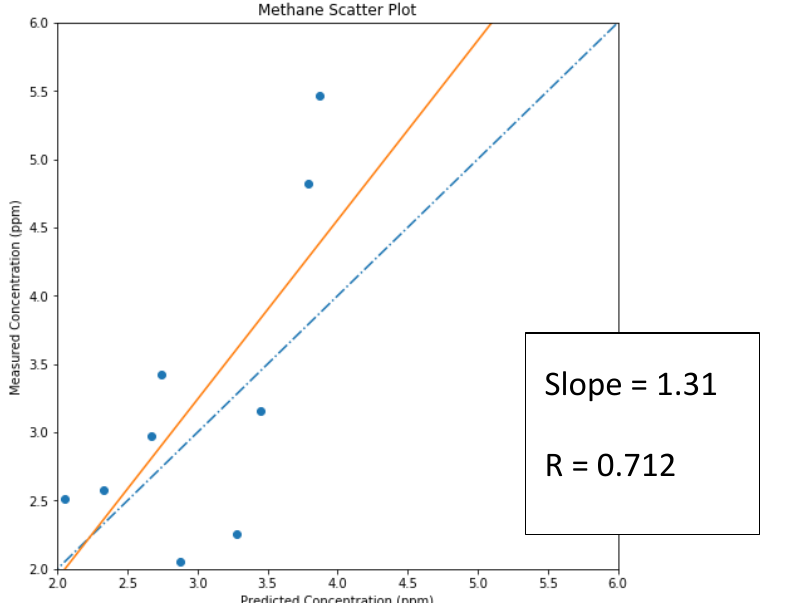
Figure 11. Scatter plot of measured methane concentrations versus modeled concentrations for 14 September 2021, 9:04 a.m. to 9:23 a.m. R denotes the correlation coefficient. The (orange) regression and (blue) 1:1 lines are also displayed.